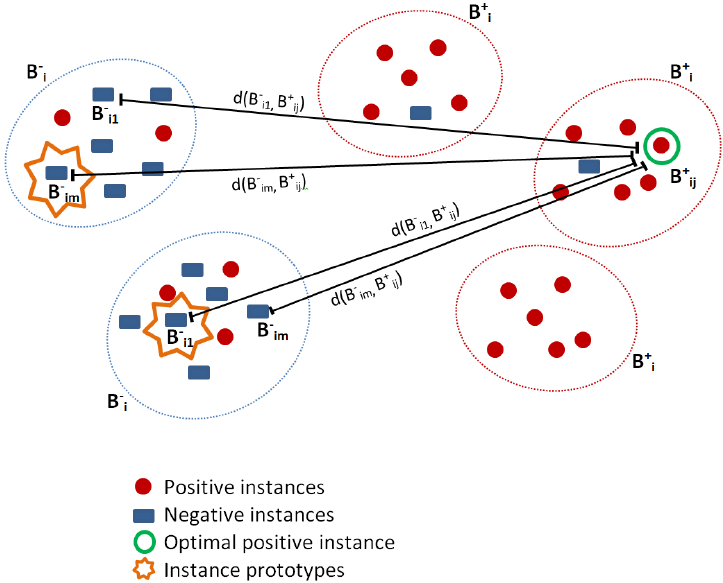
Figure 2. Selection of instance prototypes on negative bags using MILTre-SI. B + bags, B − represents negative bags and d ( B + i optimal positive and a given negative